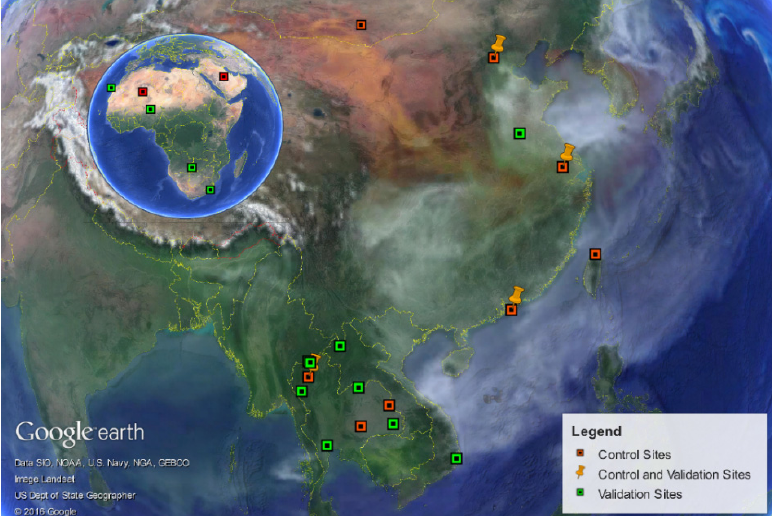
Figure 1. Location of the Aerosol Robotic Network (AERONET) sites including control sites (red squares) and validation sites (green squares) overlaid on the simulated extinction thickness of DS (red), organic/black carbon (green), sulfates (white) and sea salt (blue) from NASA Goddard Earth Observing System (GEOS-5) and the Goddard Chemistry Aerosol Radiation and Transport (GOCART) models. The figure is reproduced from the image provided on http://svs.gsfc.nasa.gov/30017 website (accessed on 21 February 2018) with the Google Earth utility.